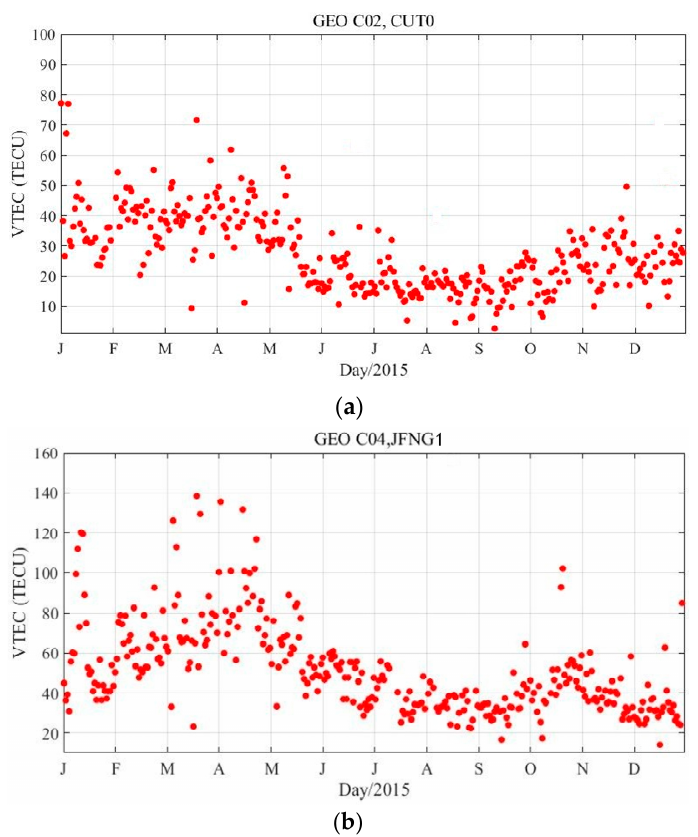
Figure 8. Daily maximum VTEC variation for GEO satellites in 2015. CUT0 ( a ), JFNG1 ( b ).